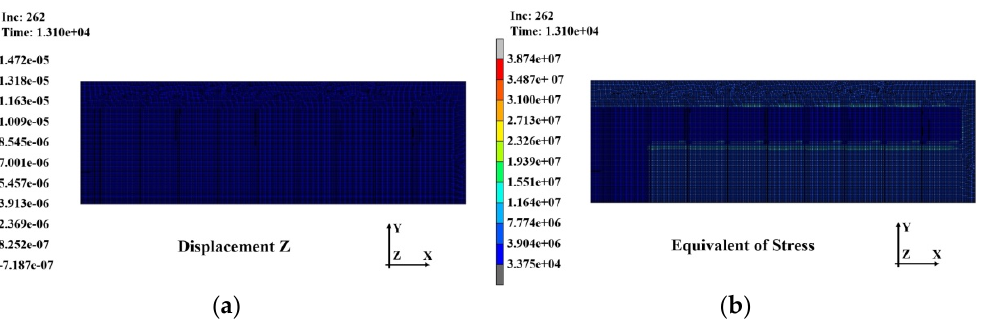
Figure 18. Analysis results of the substrate after second . laminating: ( a ) warpage distribution (14.72 μ m); ( b ) stress distribution (38.7 MPa).